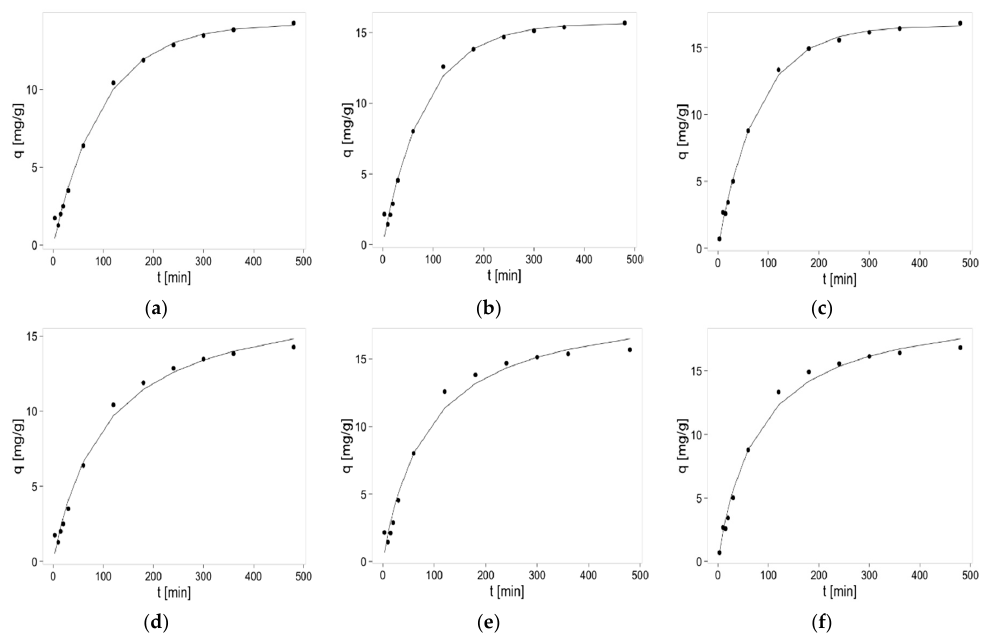
Figure 2. Sorption kinetics of zinc(II) ions on pectin—based biosorbents. Pseudo-first-order model: ( a ) hybrid pectin biosorbent with agar (P + A); ( b ) hybrid pectin biosorbent with guar gum (P + G); ( c ) sole pectin biosorbent (P) and pseudo-second order model; ( d ) hybrid pectin biosorbent with agar (P + A); ( e ) hybrid pectin biosorbent with guar gum (P + G); and ( f ) sole pectin biosorbent (P). Mass of sorbent 0.75 g, initial concentration of metal: c = 30 mg/L, volume of solution: 0.5 L, pH = 6, temperature 22 ± 1 °C.